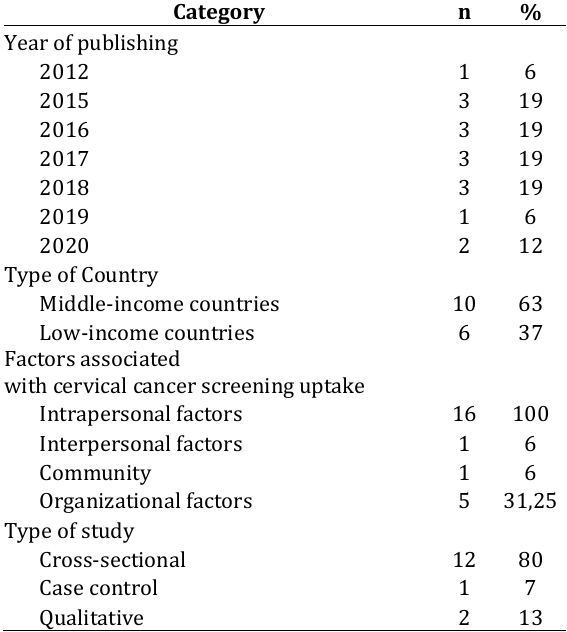
Table 1. General characteristics of the selected studies